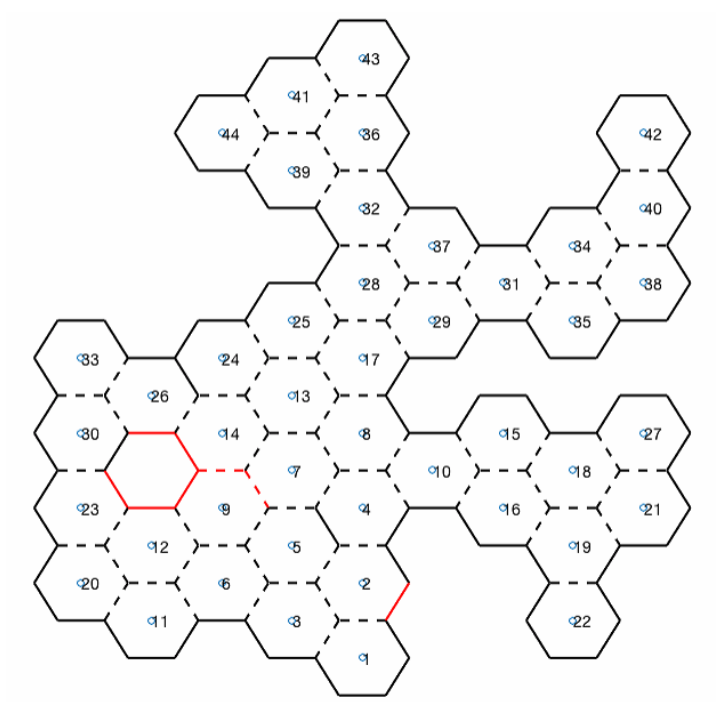
Figure 16. Honeycomb-map simulation—Scenario 1, three UAVs, Euclidean distance